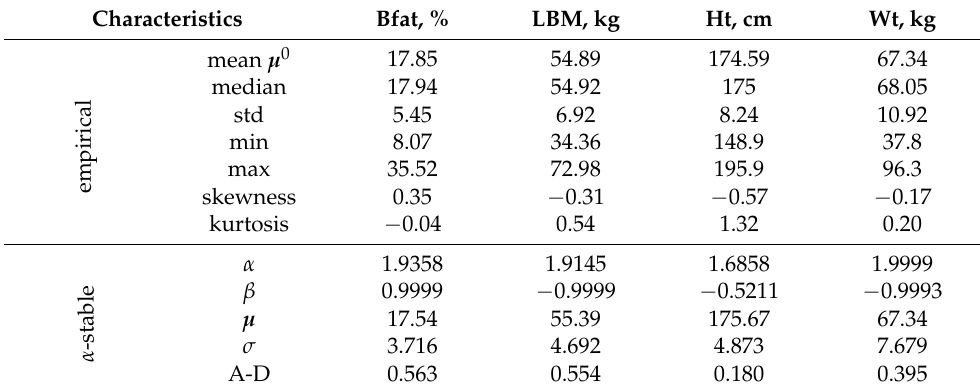
Table 3. Marginal characteristics of Australian Institute of Sport (AIS)